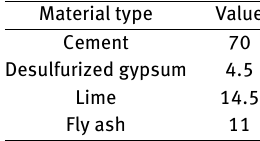
Table 5: Basis mix proportions